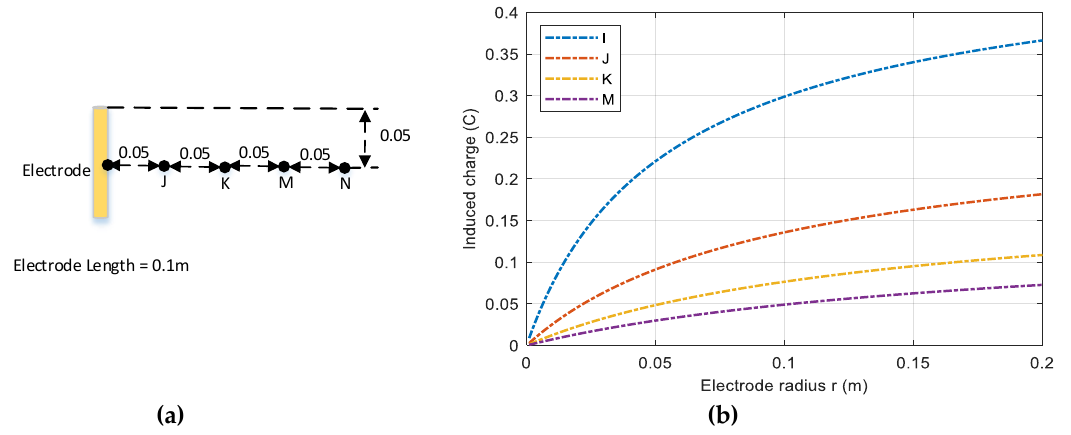
Figure 13. Effect of the electrode radius: ( a ) Positions of different point charges and ( b ) variation of the induced charge with the electrode radius under the influence of the point charge at different positions.